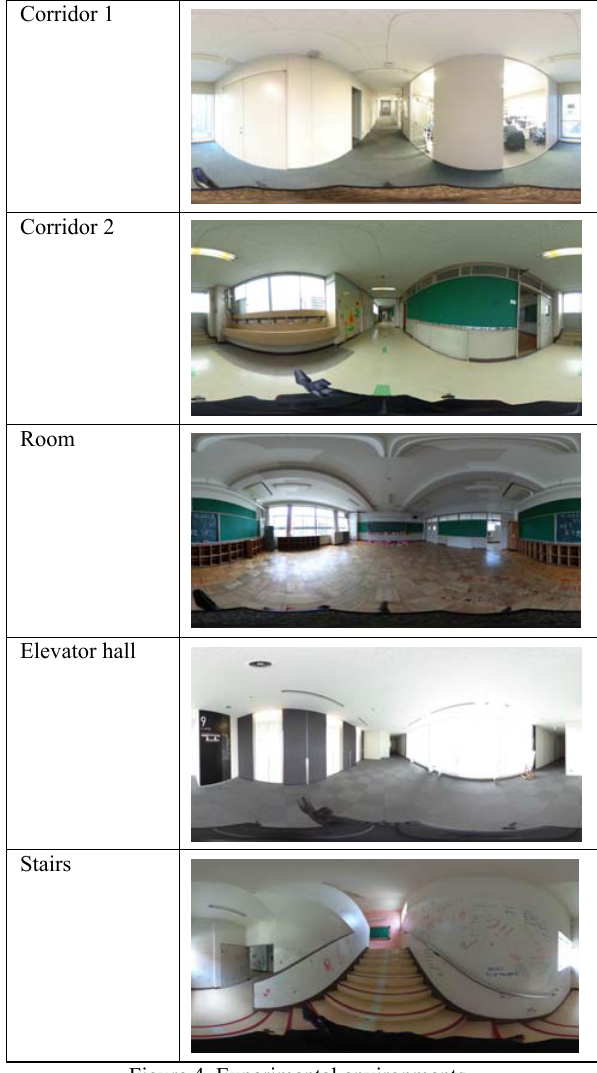
Figure 4. Experimental environments